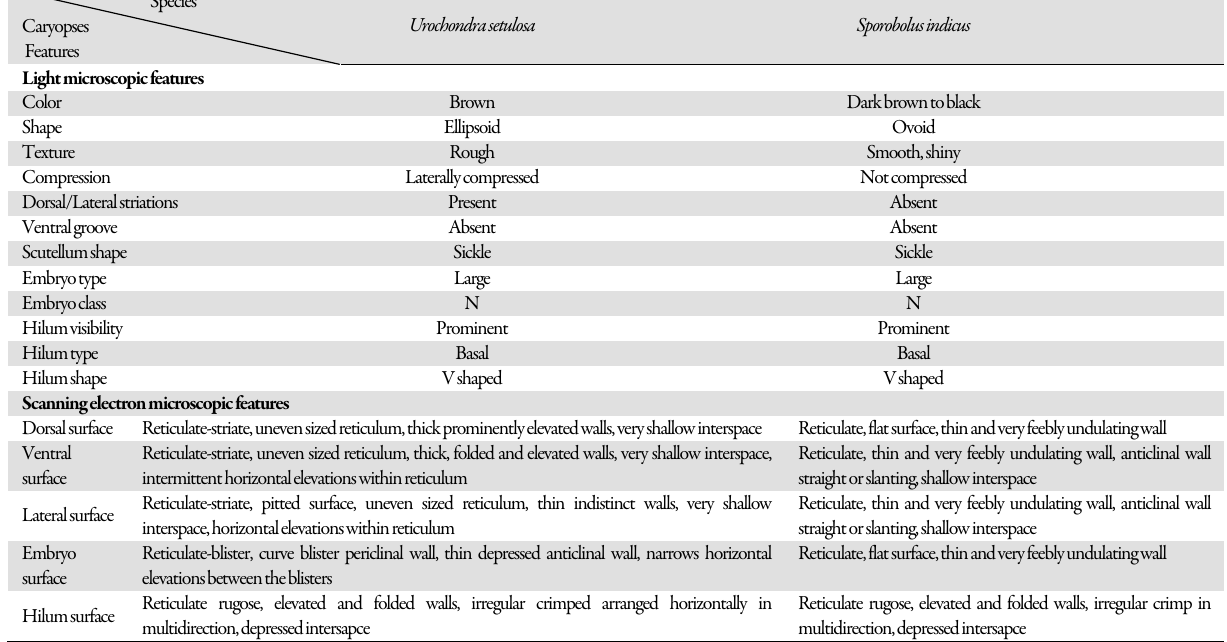
Table 3. Scanning and light microscopic features of caryopses in Urochondra setulosa and Sporobolus indicus